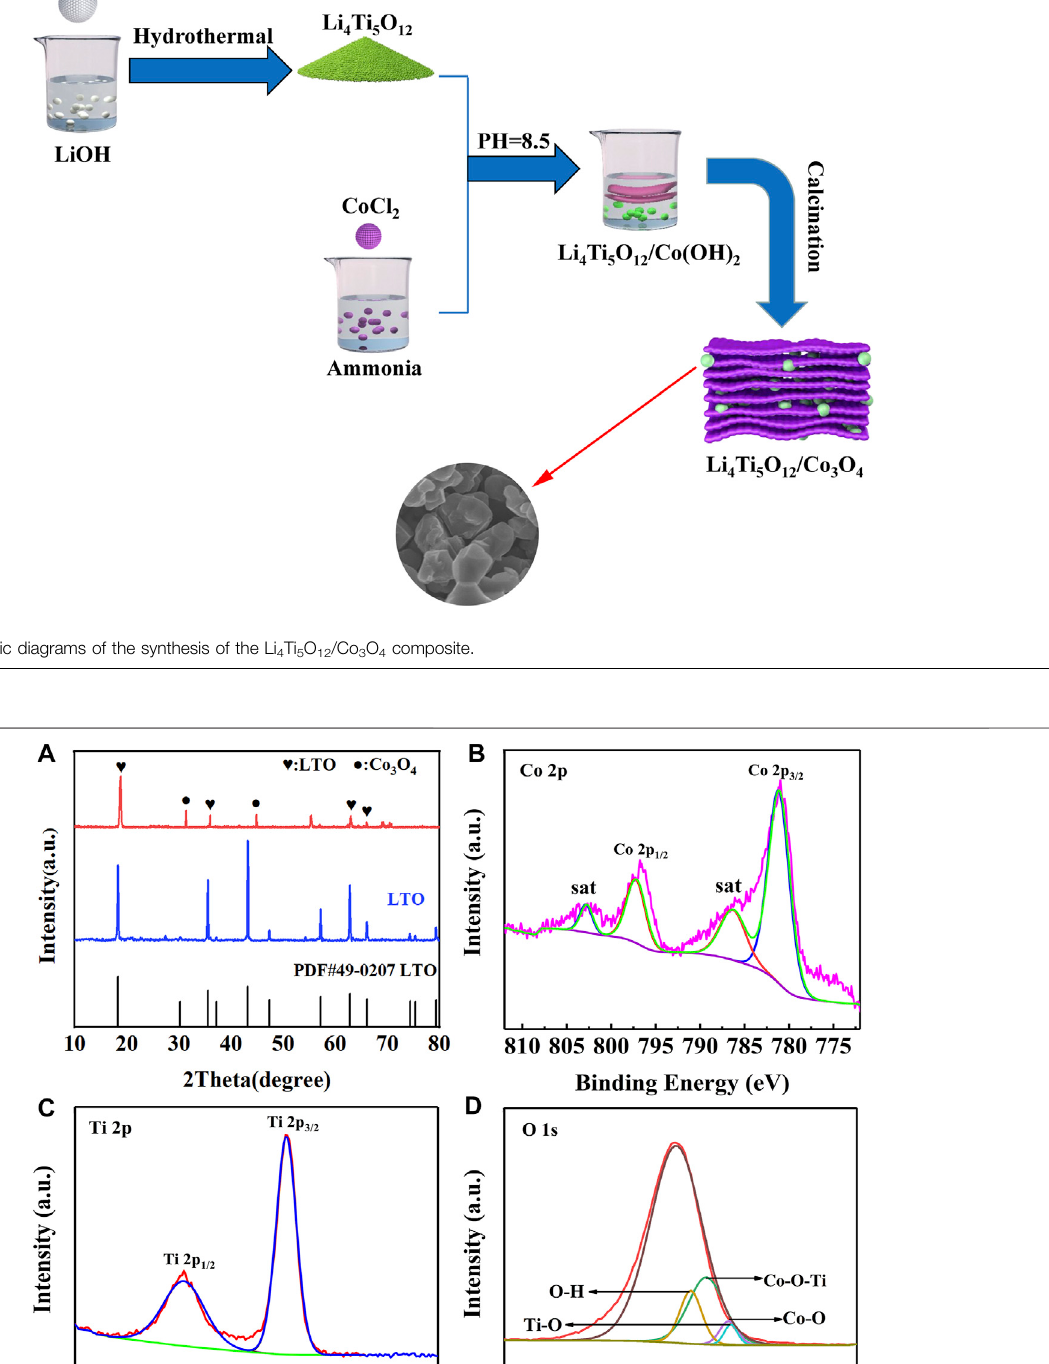
Frontiers in Chemistry |